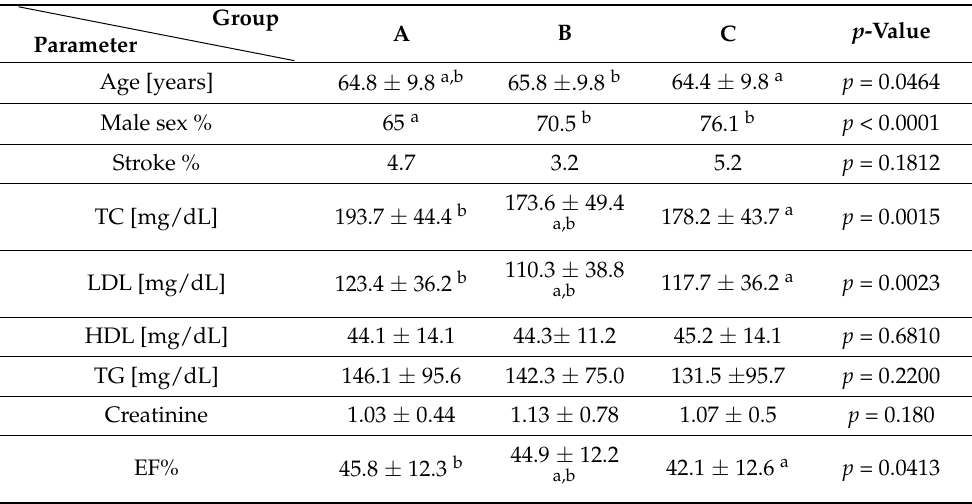
Table 3. Patient characteristics: history of cardiovascular interventions vs. history of PTCA and myocardial